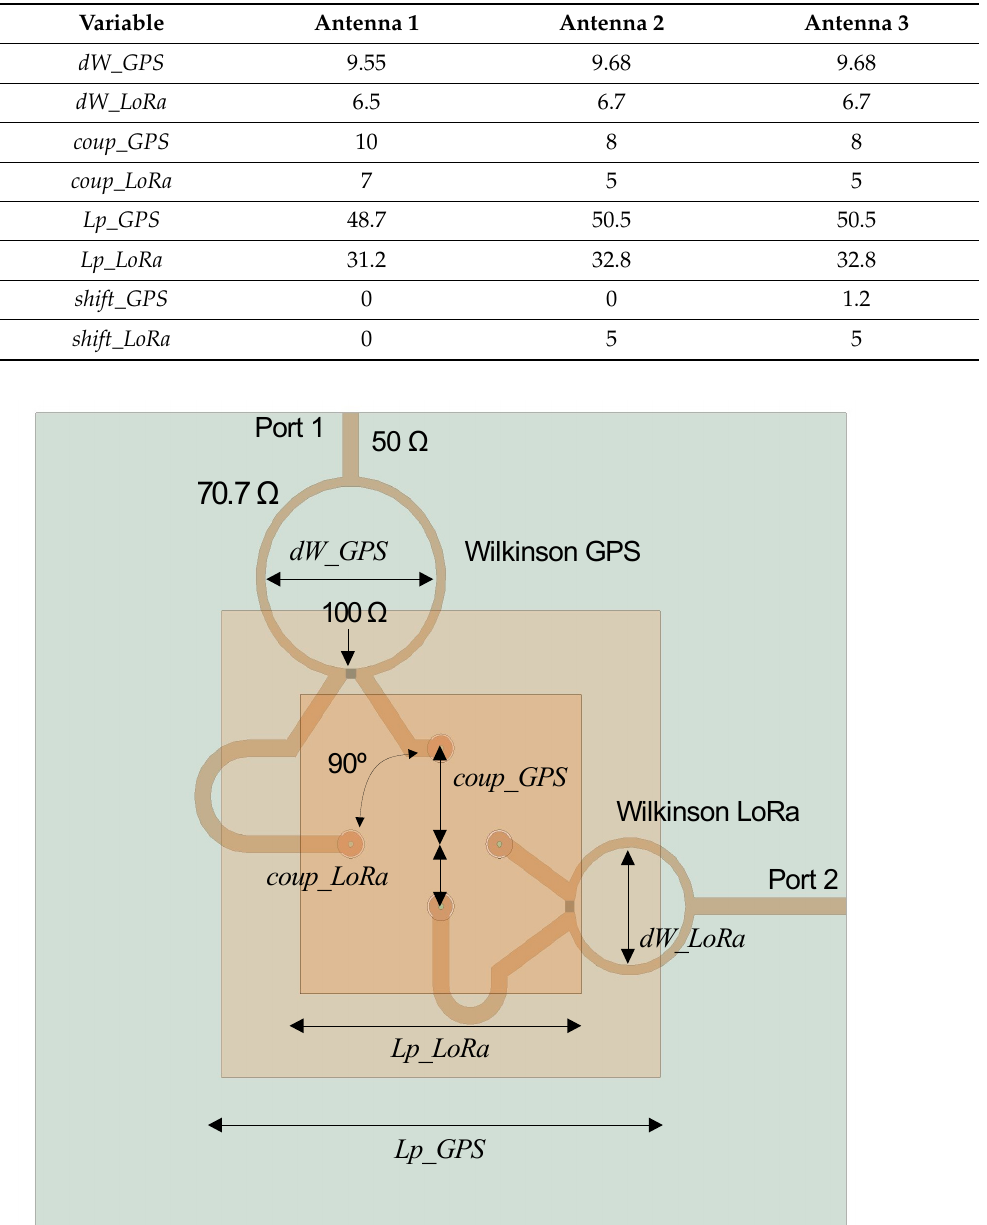
Table 1. Main dimensions (mm) of the designed antennas.